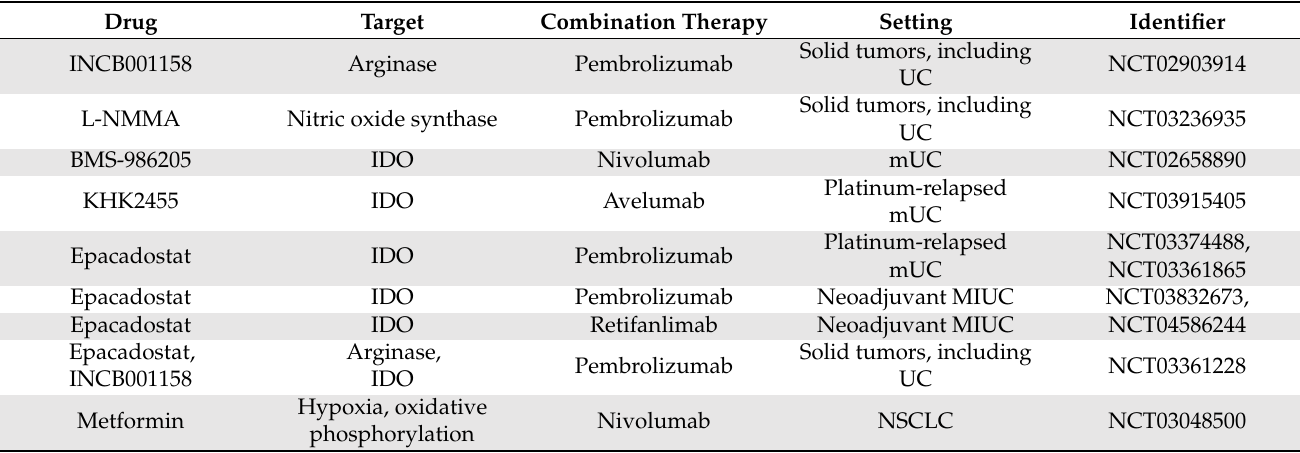
Table 1. Clinical trials investigating metabolic reprogramming for